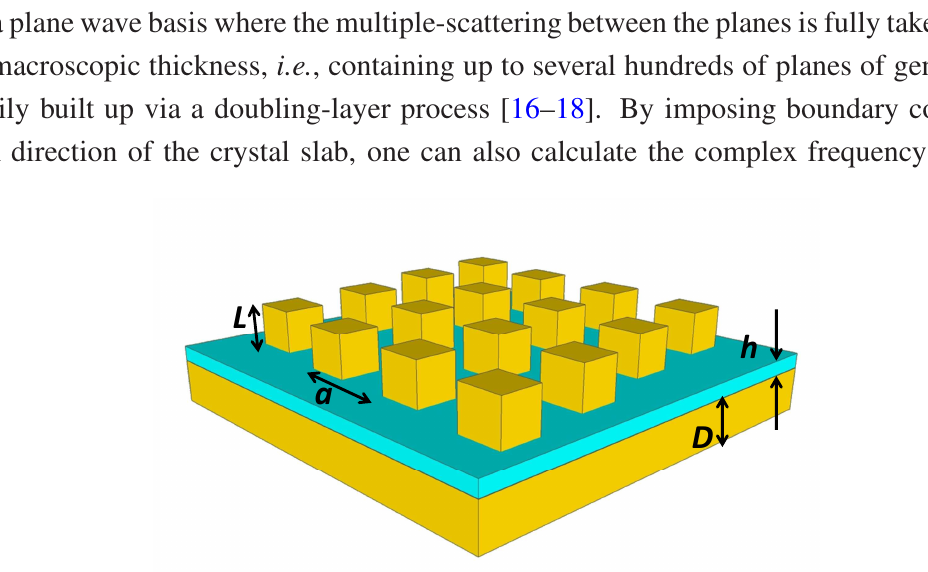
Figure 1. A square array of metallic nanocubes separated with a thin dielectric film from a metallic substrate. The lattice constant of the square array is denoted by a , the edge of the nanocubes by L , the thickness of the dielectric film by h and the thickness of the metallic substrate by D